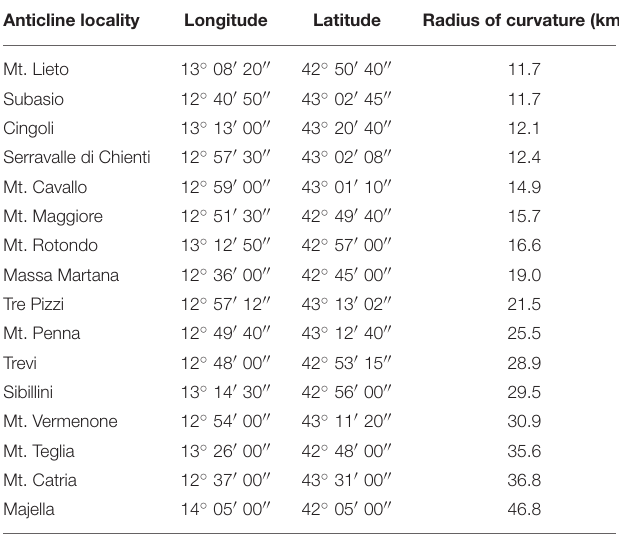
TABLE A1 | Horizontal radius of curvature (map view) for the 16 most arcuate (salient-like) anticlines of central-northern Apennines, Italy. Anticline locality